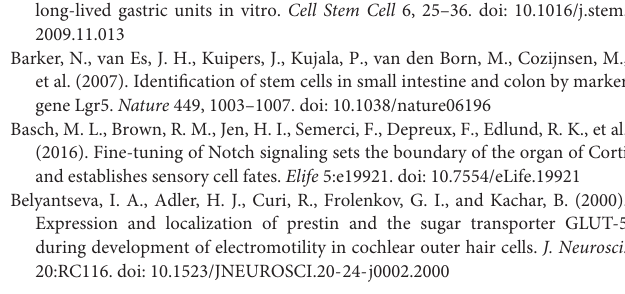
FIGURE S1 | Expression levels of the top 200 genes in Lgr5 + progenitors and Lgr6 + progenitors. (A) Expression levels of the top 200 genes in Lgr5 + progenitors in descending order. Numbers in red on the right side of each panel represent the ranking of the same genes in Lgr6 + progenitors. (B) Expression levels of the top 200 genes in Lgr6 + progenitors in descending order. Numbers in blue on the right side of each panel represent the ranking of the same genes in Lgr5 + progenitors. FIGURE S2 | Lgr5 and Lgr6 expression in the sensory epithelium of P3 cochleae. At P3, there was only one row of Lgr6 + cells in the middle and basal turns of the cochlea, but Lgr6 + did not expressed in the apical turn of cochlea, while Lgr5 expression was similar from the apex to the base in the sensory epithelium. FIGURE S3 | Sox4 expression in the sensory epithelium at P3 cochlea. At P3, Sox4 expressed in all of SCs, including first row of Deiters’ cells (DC1), the second row of Deiters’ cells (DC2), DC3, IP, outer pillar cells(OP), the lesser epithelial ridge (LER) and the GER. TABLE S1 | The Primers for the q-PCR